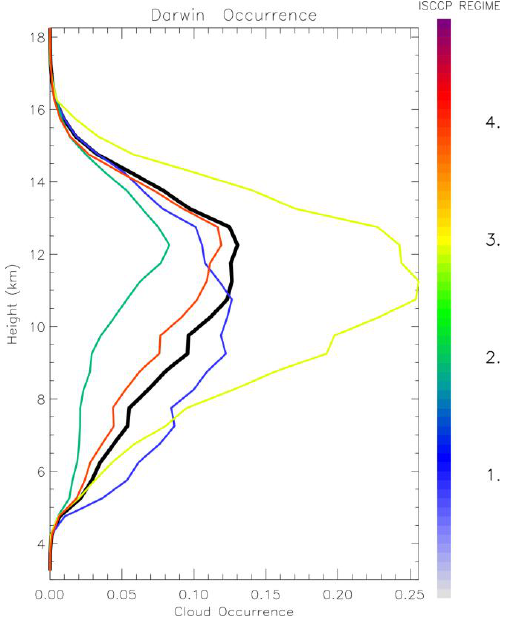
red line), and Shallow Westerly (thin red line).